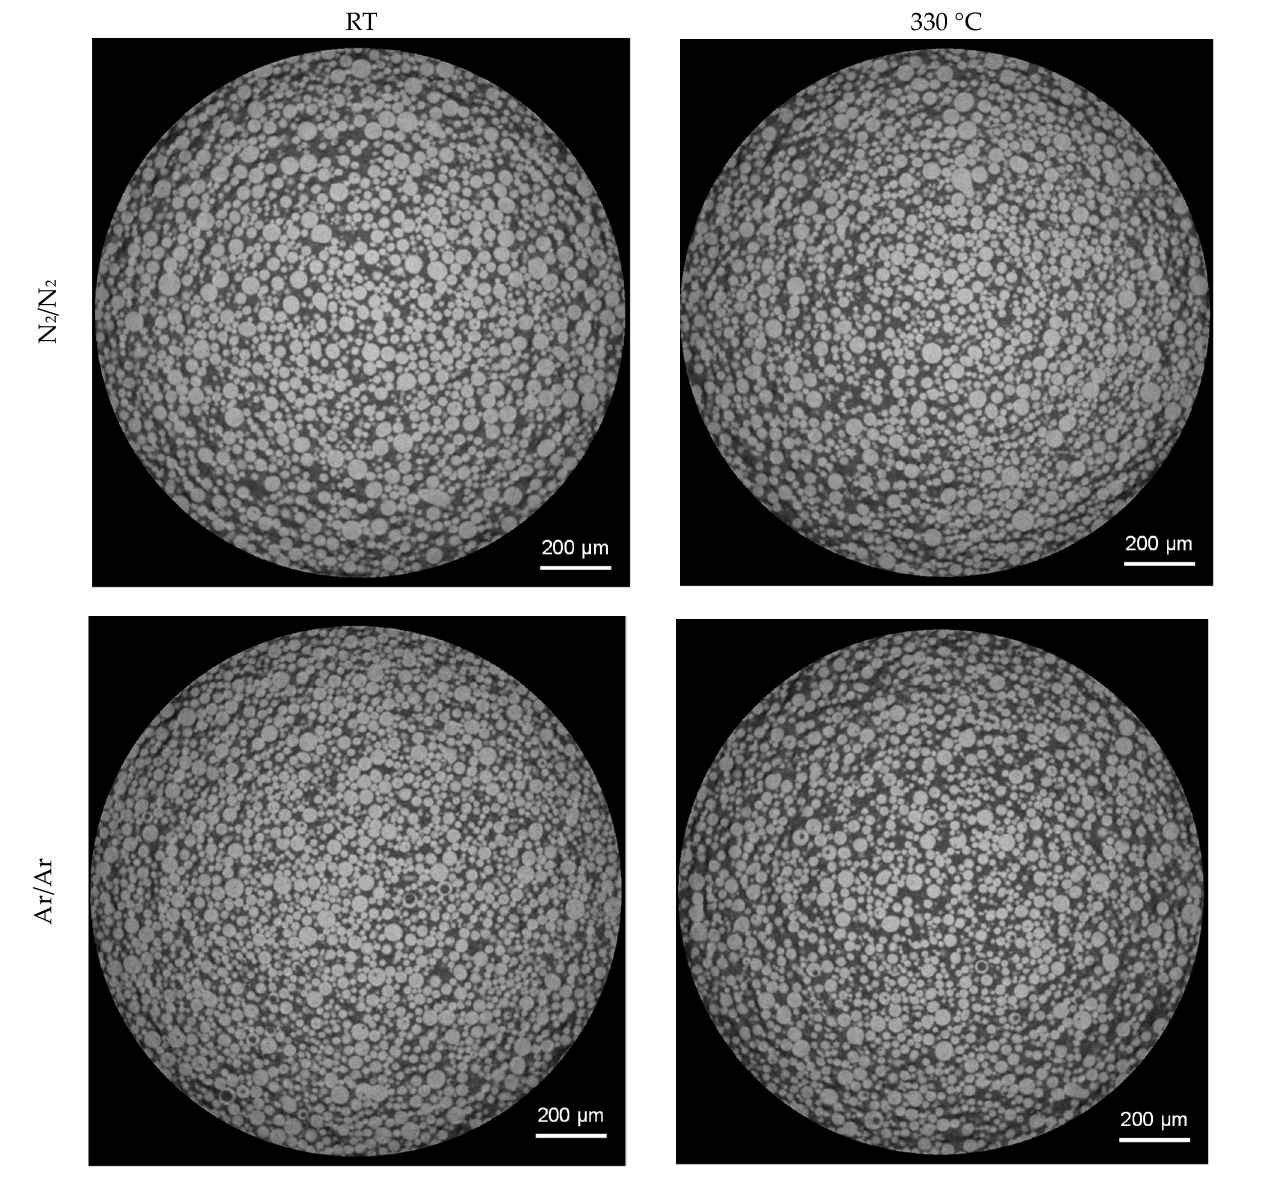
Figure 7. XRM images of gas-atomized X2CrNiMoCuWN25-7-4 powders (particle size 20–63 µm, voxel size 1.56 µm).